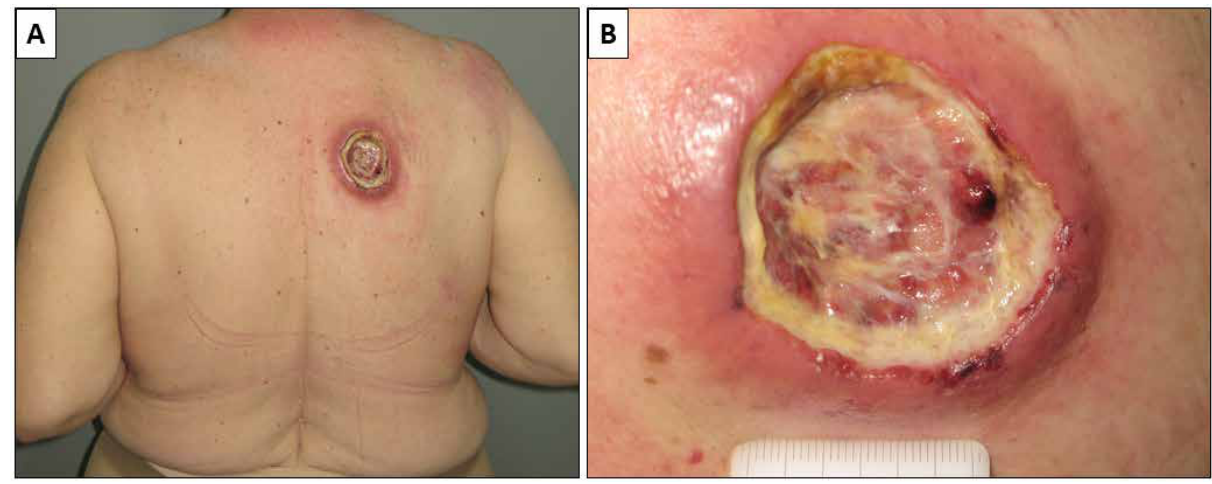
Figure 1: Clinically, the patient presented with a large nodular ulcerated lesion on her back (A). The lesion was extensively ulcerated and covered by fibrin (B).